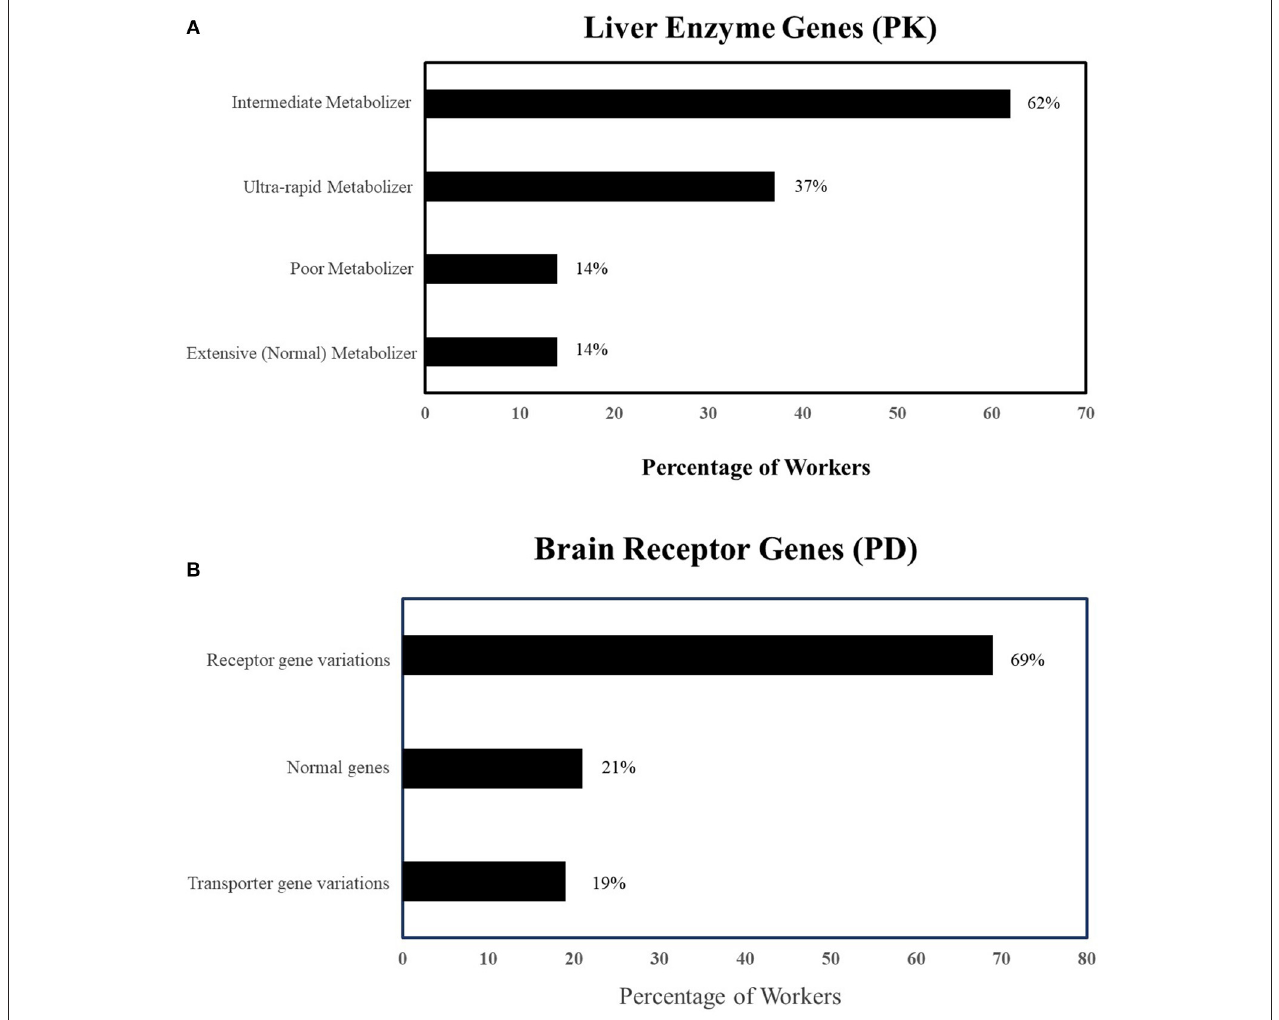
FIGURE 2 | (A) Prevalence of pharmacokinetic genetic variations in 84 patients on mental health-related disability (PK, Pharmacokinetics; UM, Ultra-rapid metabolizer; IM, Intermediate metabolizer; PM, Poor metabolizer). (B) Prevalence of pharmacodynamic genetic variations in 84 patients on mental health-related disability. PD, Pharmacodynamics, Mutated Receptors: HTR2A, DRD2 etc.; Mutated Transporters: